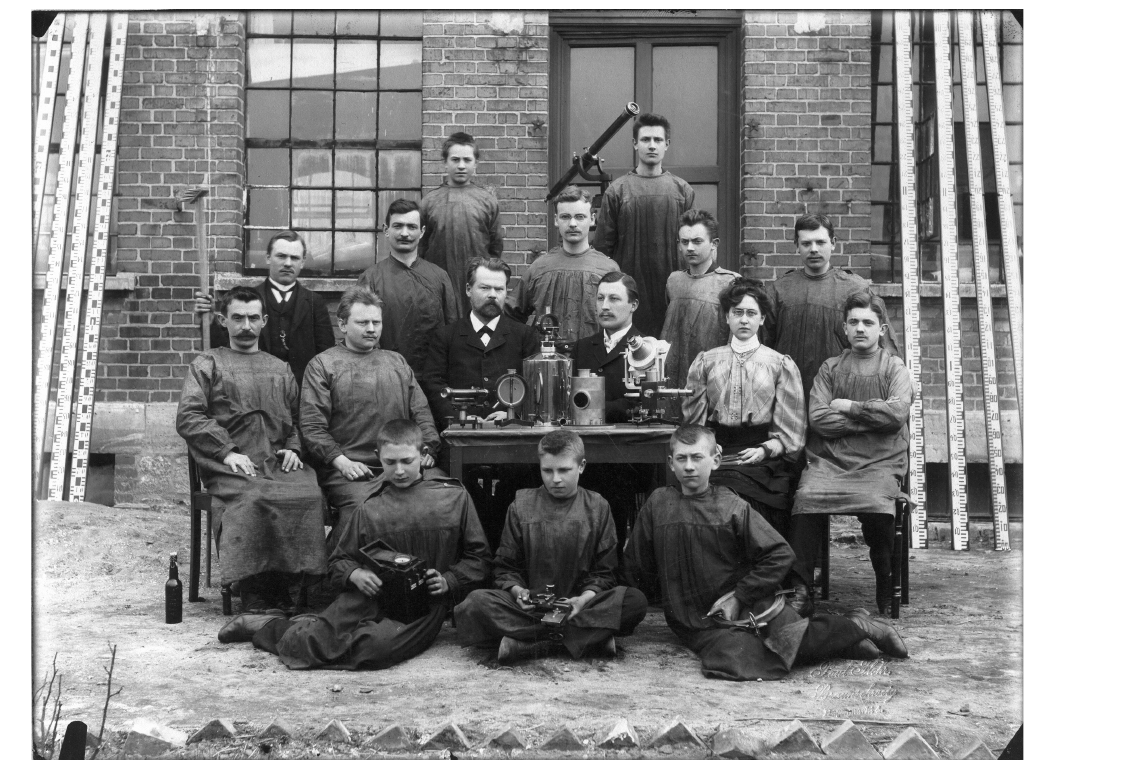
Figure 8. Oscar G¨unther and Otto Tegetmeyer (behind the table in the dark suits) with their sta ff in 1907. Displayed on the table are some instruments of their